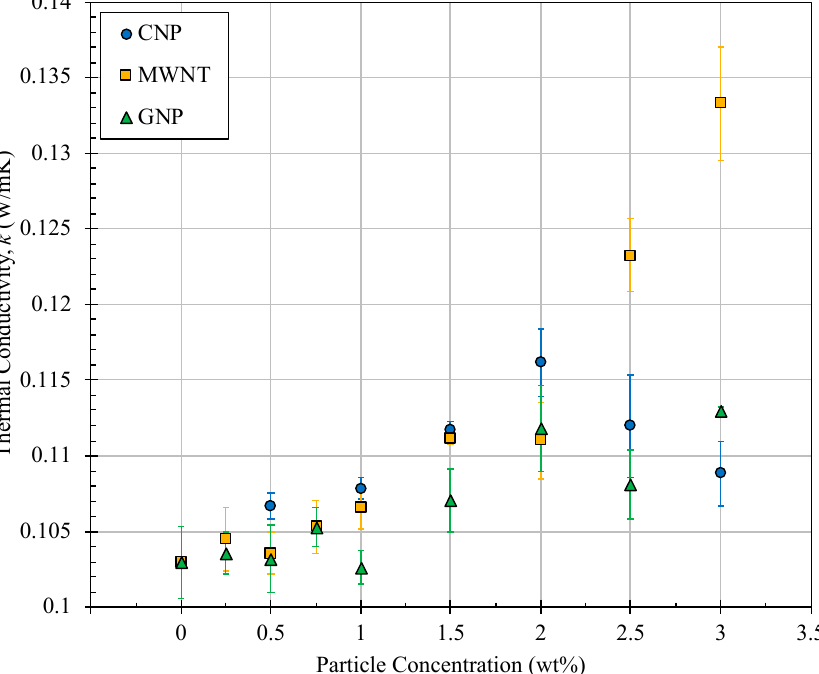
Figure 3. Variation of thermal conductivity of jet fuel as a function of added nanoparticle type and concentration.